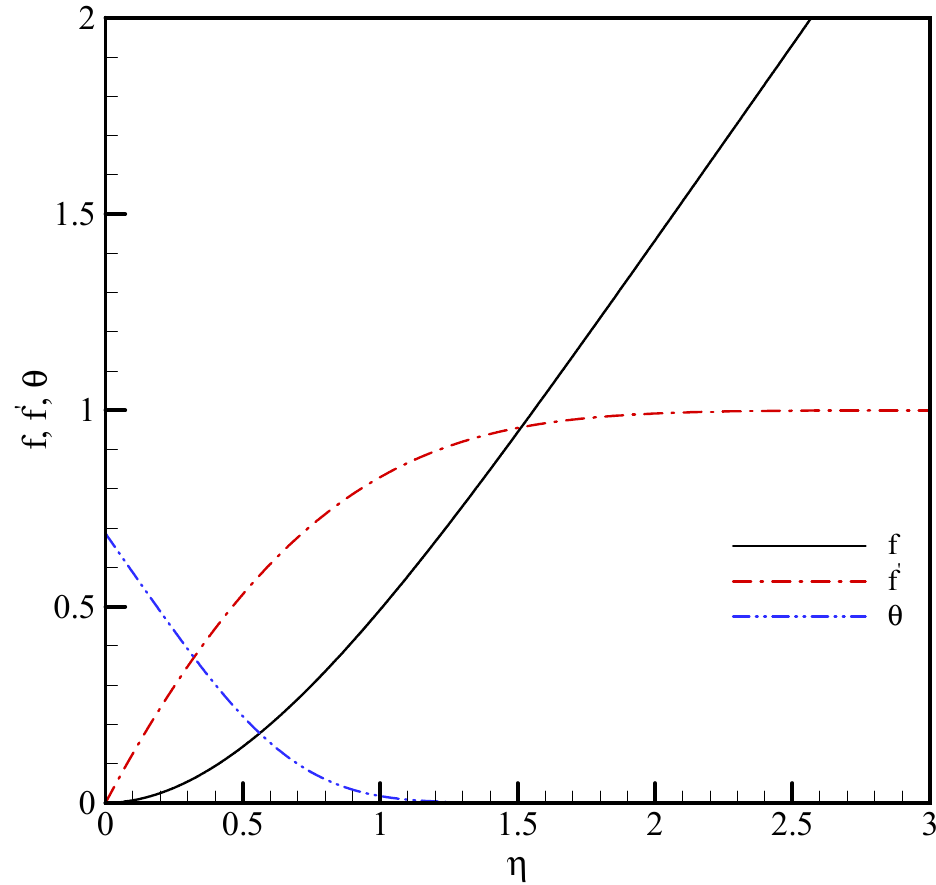
′ θ ) and temperature ( ) profiles in the stagnation region.